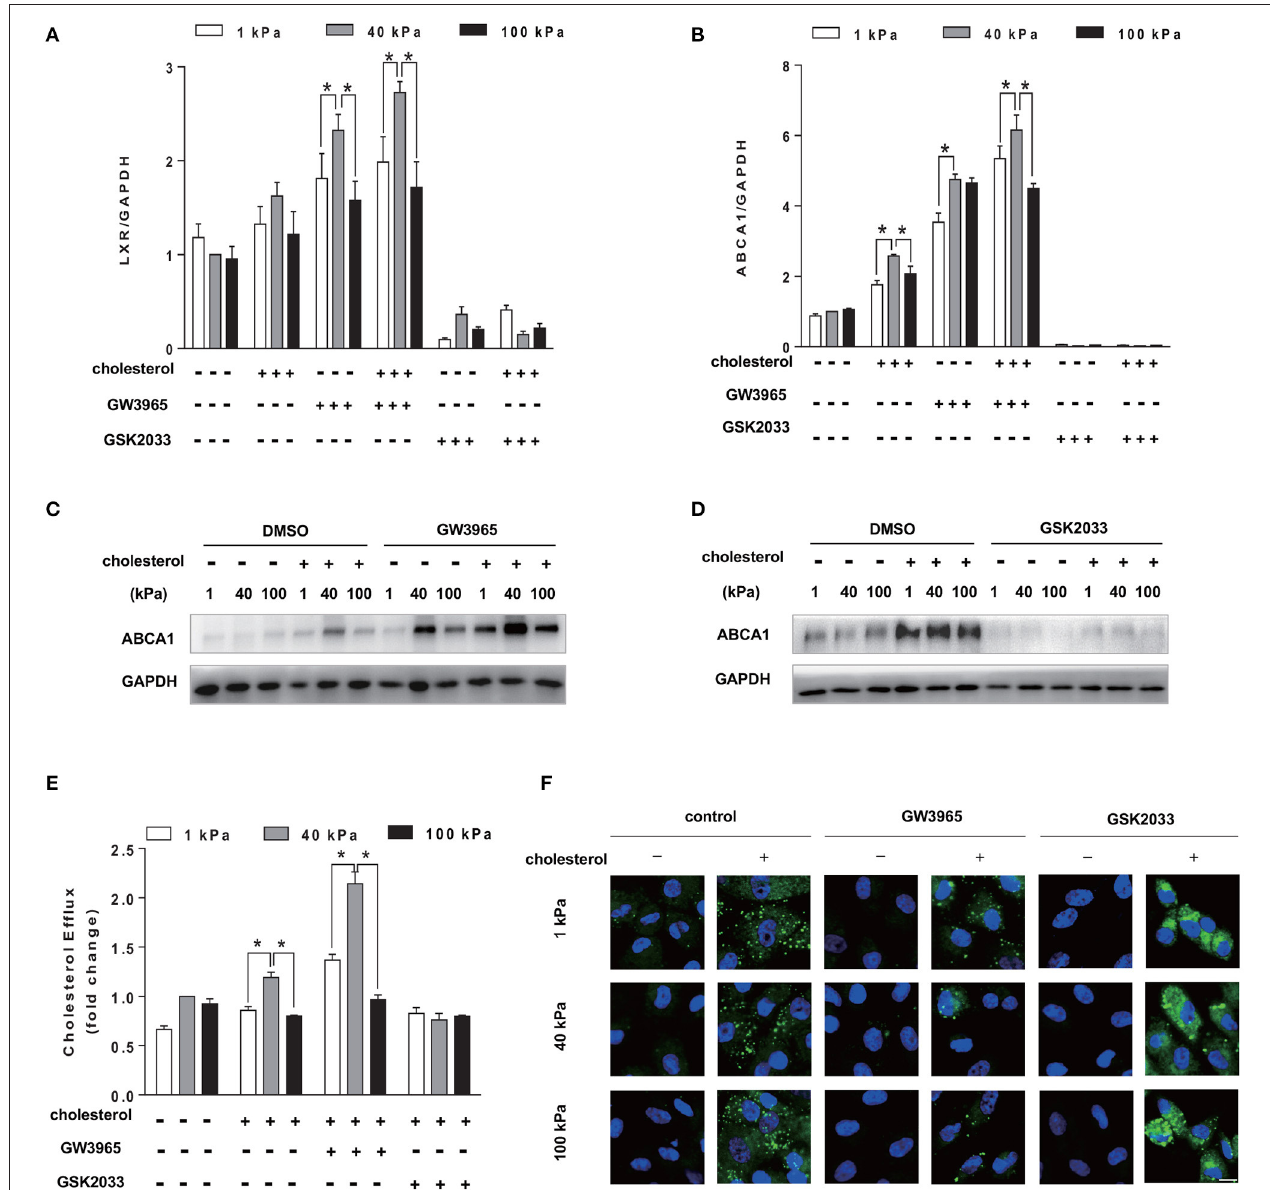
FIGURE 5 | Additive effect of substrate stiffness and LXR signaling pathway on ABCA1 expression and cholesterol efflux. SMCs were seeded on substrate with different stiffness and treated with 20 µ g/ml Chol: M β CD and GW3965 (1 µ M) or GSK2033 (1 µ M) in the serum-free medium for 72 h. (A,B) LXR and ABCA1 gene expression level was measured by RT-qPCR. GAPDH was used as the internal control for normalization ( n = 3). (C,D) ABCA1 protein expression was analyzed by Western blotting analysis after GW3965 or GSK2033 treatment. DMSO was used as control. The expression of GAPDH was used as the internal control ( n = 3). (E) Cholesterol efflux rate. The results were expressed as fold change of all groups compared with the control group at 40 kPa ( n = 3). (F) The cholesterol accumulation in SMCs after GW3965 or GSK2033 treatment (green: BODIPY 493/503 staining of cholesterol; blue: DAPI staining of nucleus, scale bar = 10 µ m). ∗ p < 0.05.